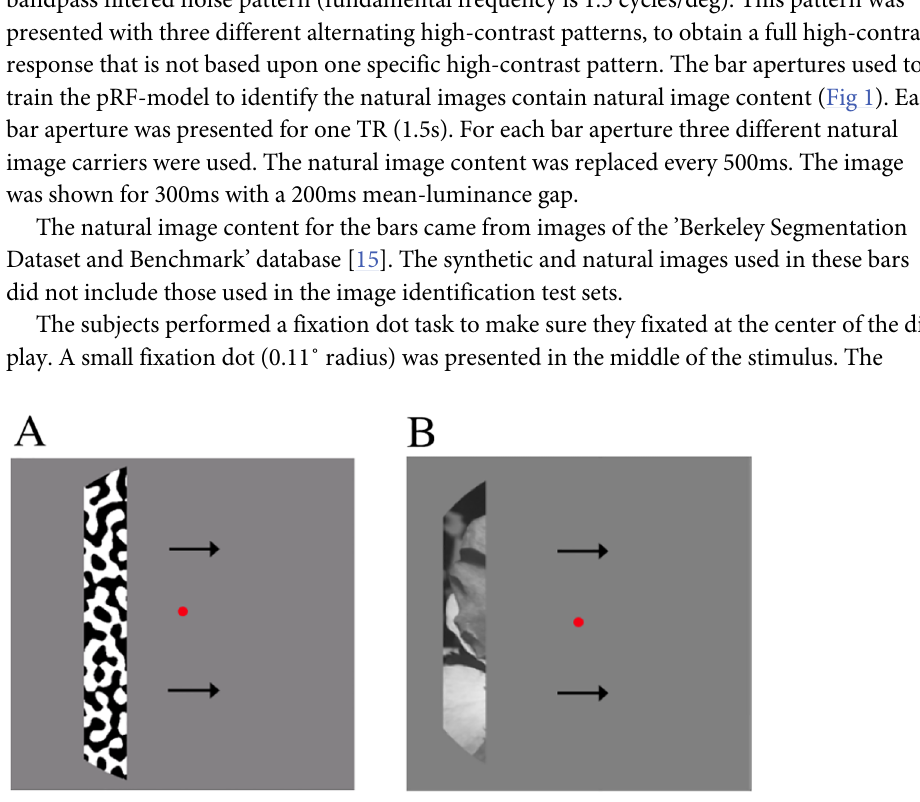
Fig 1. Examples of the pRF mapping stimuli used to estimatethe pRF properties. The stimuli were either filled with a binarizedbandpass filtered noise pattern (A) or natural image content